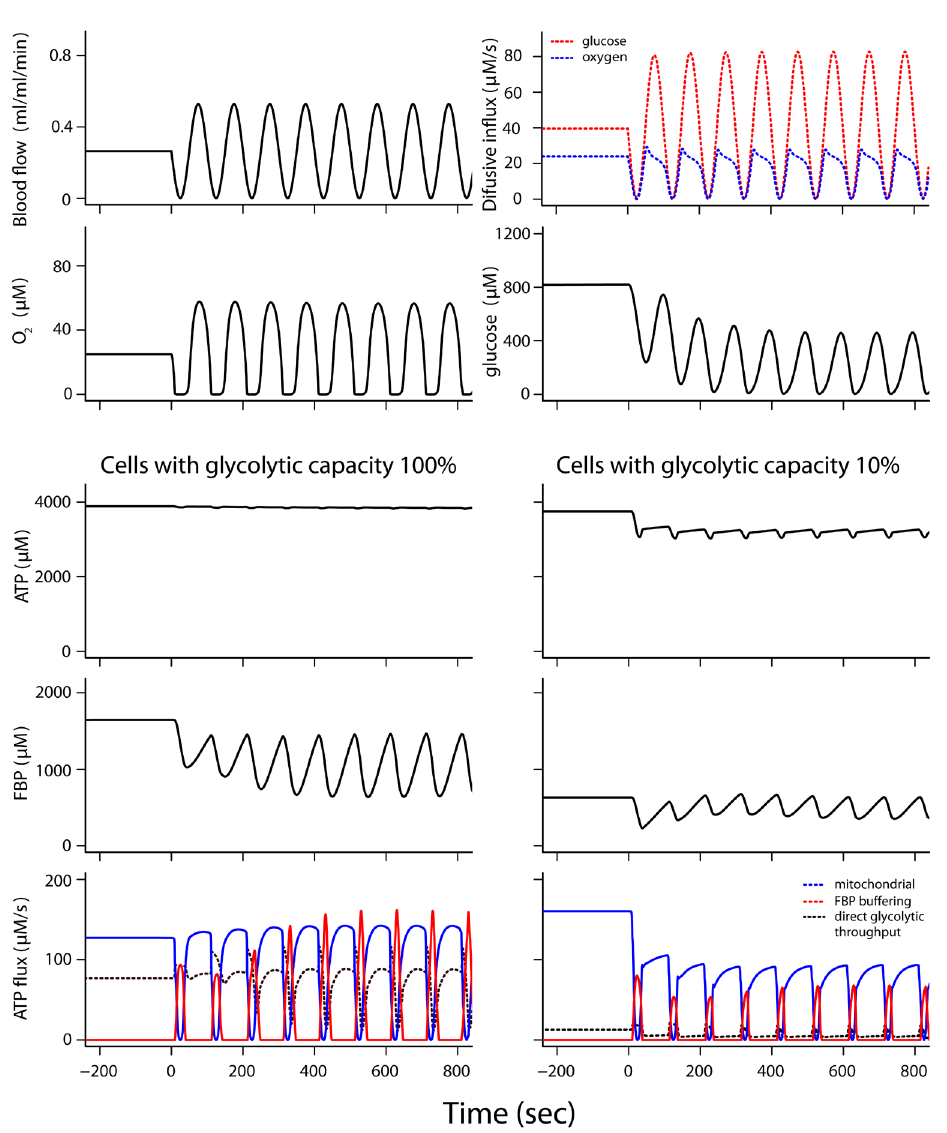
Figure 4. Simulations predicting tumor tissue metabolism during the start of blood flow cycling. In this simulation, 80% of the cell volume had the full tumor glycolytic capacity; 20% of the cell volume had 10% of the full glycolytic capacity. This means that the V of the max head and tail section had 10% of the value for EATC. The top two rows show tissue conditions experienced by both cell types. Blood flow and diffusion flux of glucose and O from the microvessel into tissue are given (top row). O and glucose concentrations seen by both cell types 2 2 are given in the second row. The simulation is for cells at ~18 µm from the microvessel. High ATP consumption, >160 µM/s, was maintained at constant blood flow. See legend to Figure 3 for description of ATP synthesis fluxes. When blood flow started to fluctuate at t=0, ATP synthesis from the stored fructose 1,6-bisphosphate (FBP) and other phosphorylated glycolytic intermediates (red curve) maintained ATP levels and high ATP hydrolysis rates in cells with full tumor glycolytic capacity; however, there was a drop in ATP level and ATP hydrolysis rate in the cells with reduced glycolytic